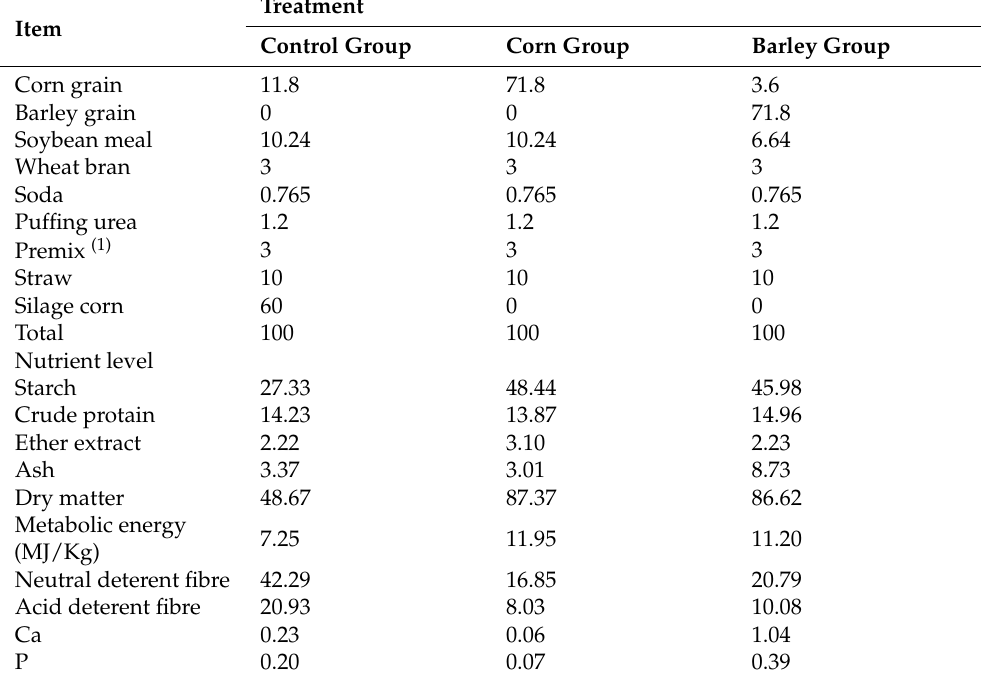
Table 3. Phase III dietary formulations and components (DM)